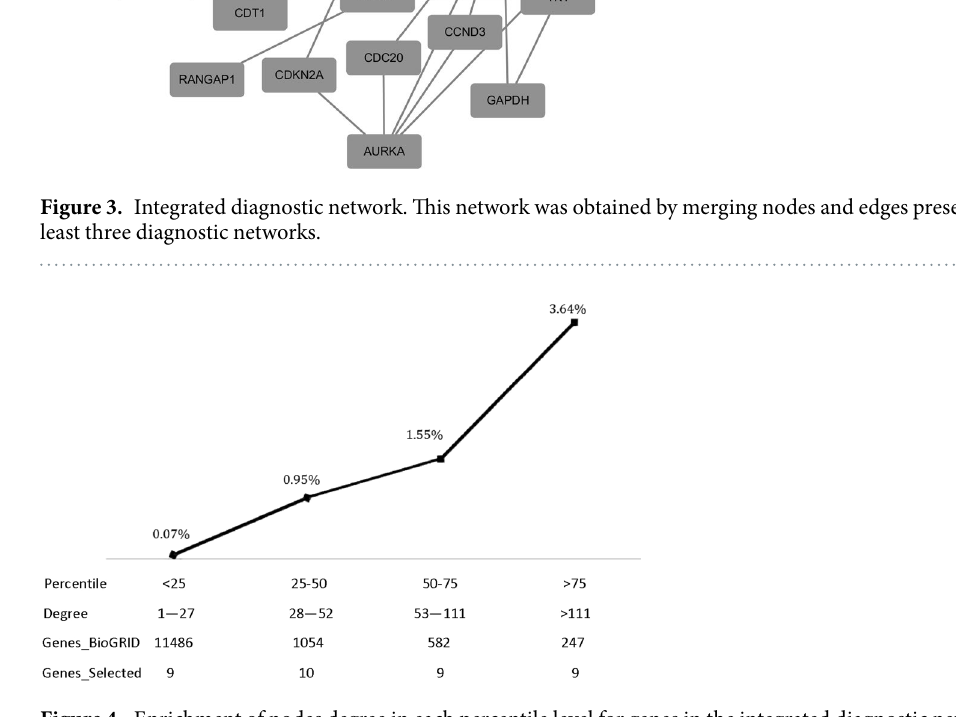
lower 25 percentile, 25 to 50 percentile and 50 to 75 percentile groups (Fig. 4). Permutation test with 1000 runs show that the high enrichment (3.64%) of the highly connected group ( > 75% percentile degree) in the integrated diagnostic network is not obtained by chance (p = 0.005).